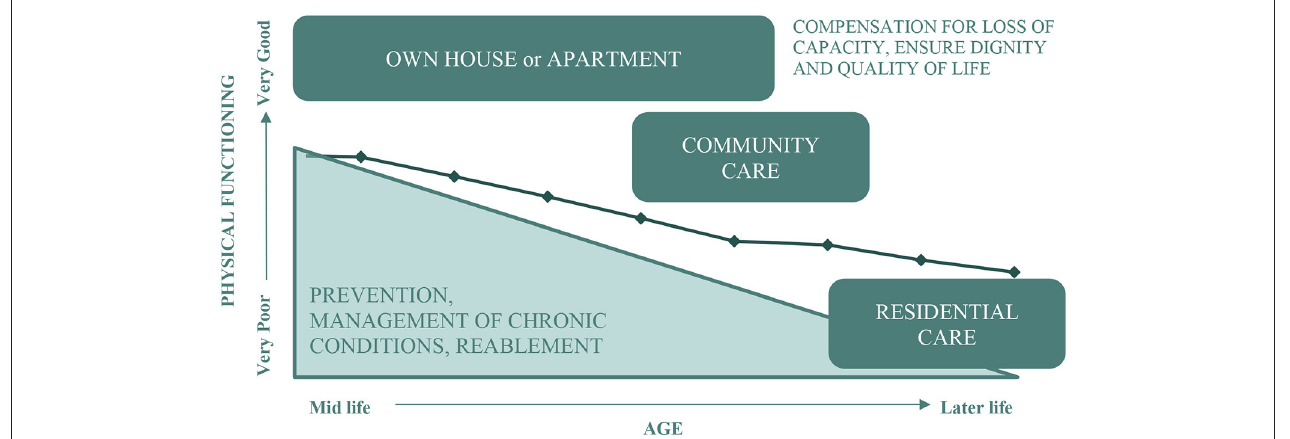
FIGURE 1 | Conceptual model of the association between physical functioning, housing, and the needs for